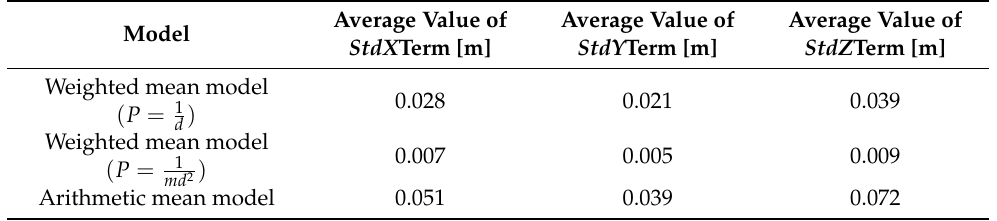
Table 3. The comparison of ( StdX , StdY , StdZ ) parameters.